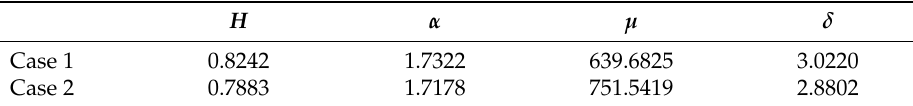
Table 2. Parameter estimation of forecasting model.